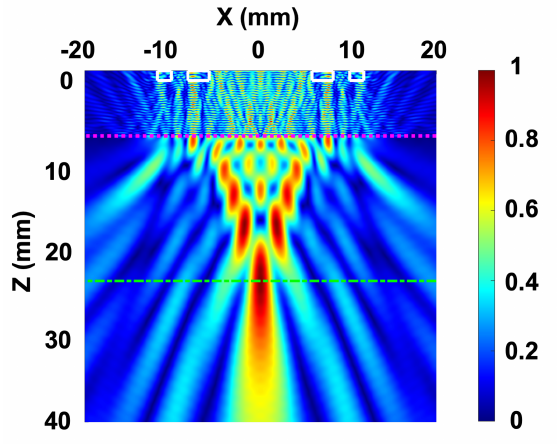
Figure 4. Numerical results of the normalized acoustic pressure with a 6.5 mm water